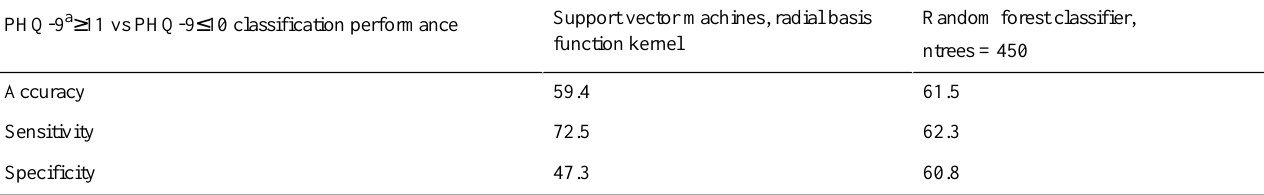
Table 4. Classification performance of support vector machines and random forest